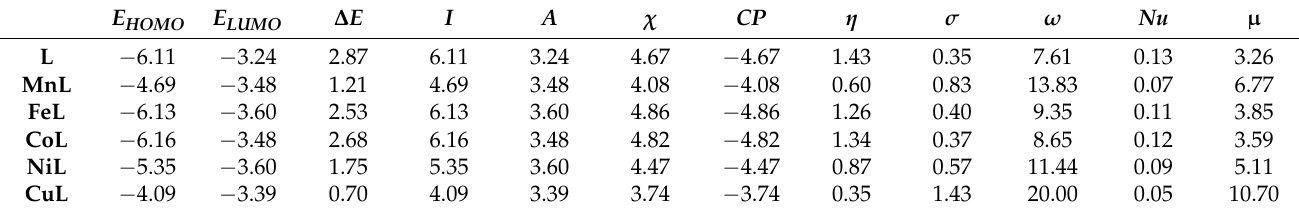
Table 3. Calculated DFT parameters of the subject compounds.